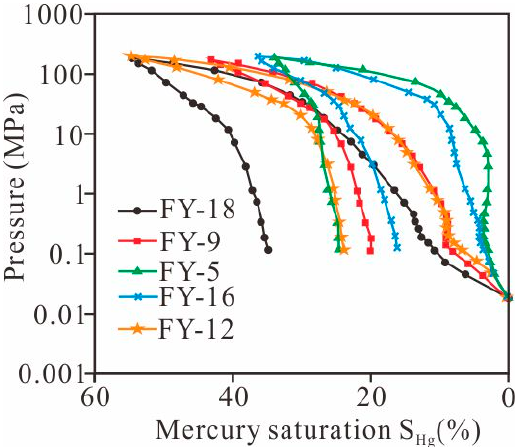
Figure 6. The capillary pressure curves of five typical types of lithofacies. Sample FY-5 of ML; sample FY-12 of SS; sample FY-9 of AS; sample FY-16 of MS; sample FY-9 of CS.